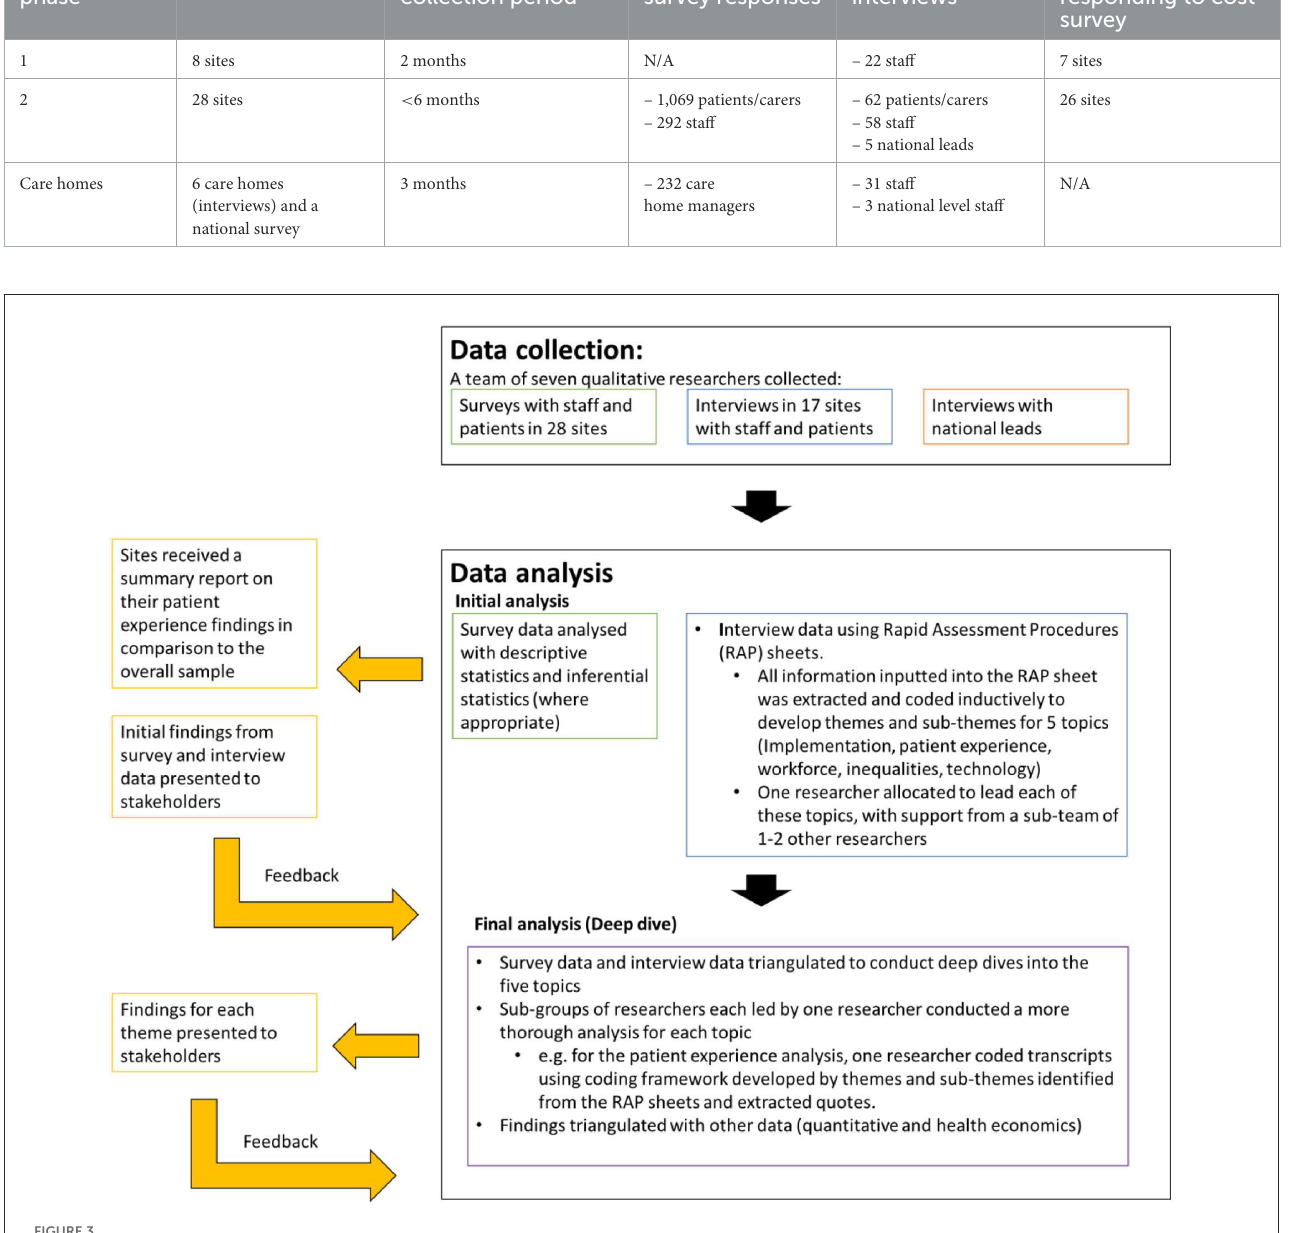
FIGURE3 Data collection and analysis processes, together with feedback loops for the Phase 2